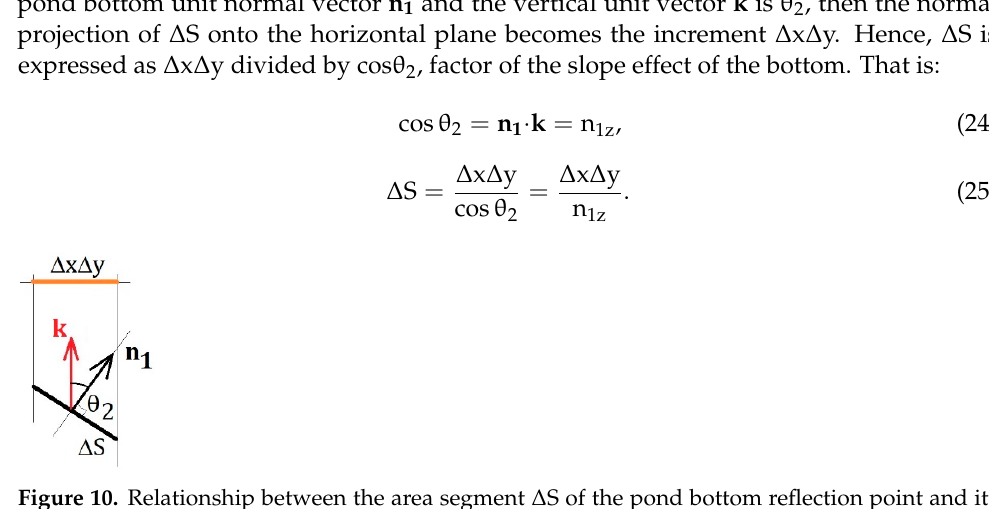
Figure 9. Unit normal vector n 1 at the pond bottom and unit direction vector B 1 of the irregularly reflected light at the pond bottom.